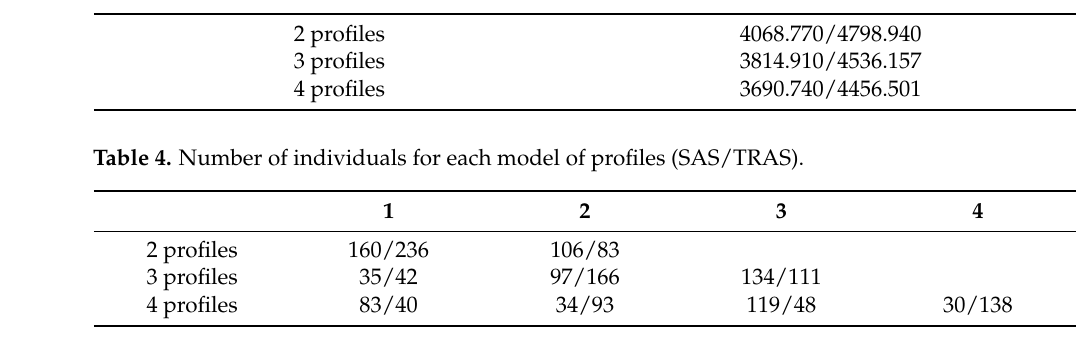
Table 3. SABIC (Sample-Size Adjusted BIC) (SAS/TRAS).